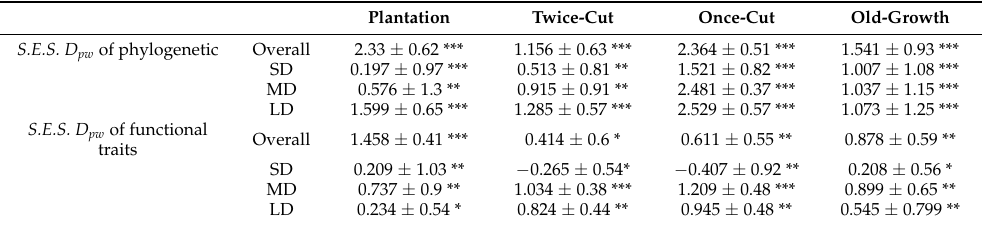
Table 4. Phylogenetic and functional standardized mean pairwise distances (mean S.E.S. Dpw ± SE) between disturbance communities. SD, MD, and LD represent small, medium, and large diameter classes, respectively. “*”, “**” and “***” represent p < 0.05, p < 0.01, and p < 0.001,